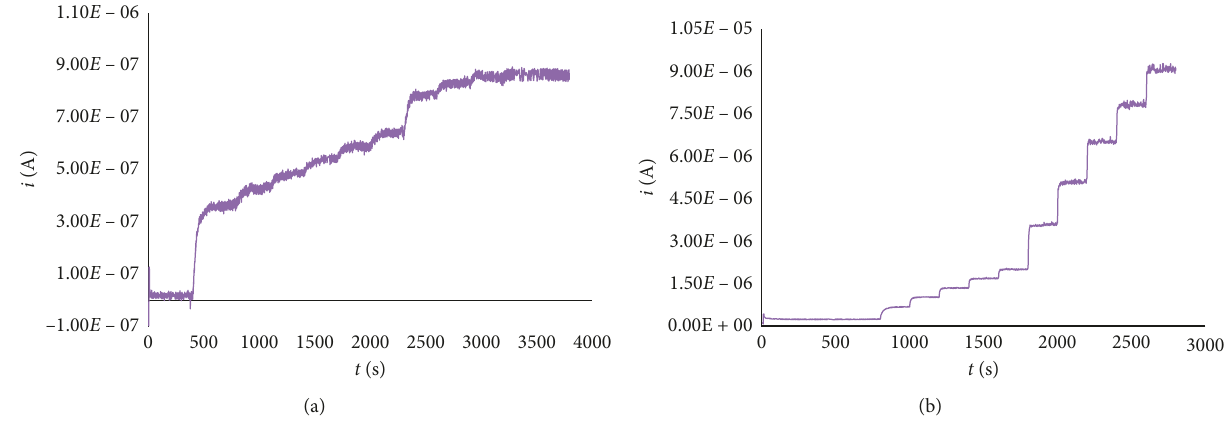
Figure 3: Current/time response of the biosensor poly(2,2